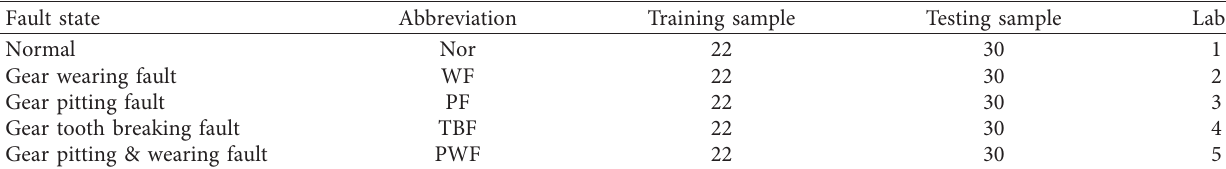
Figure 16: The gearbox test platform. Table 4: The brief information of gear vibration